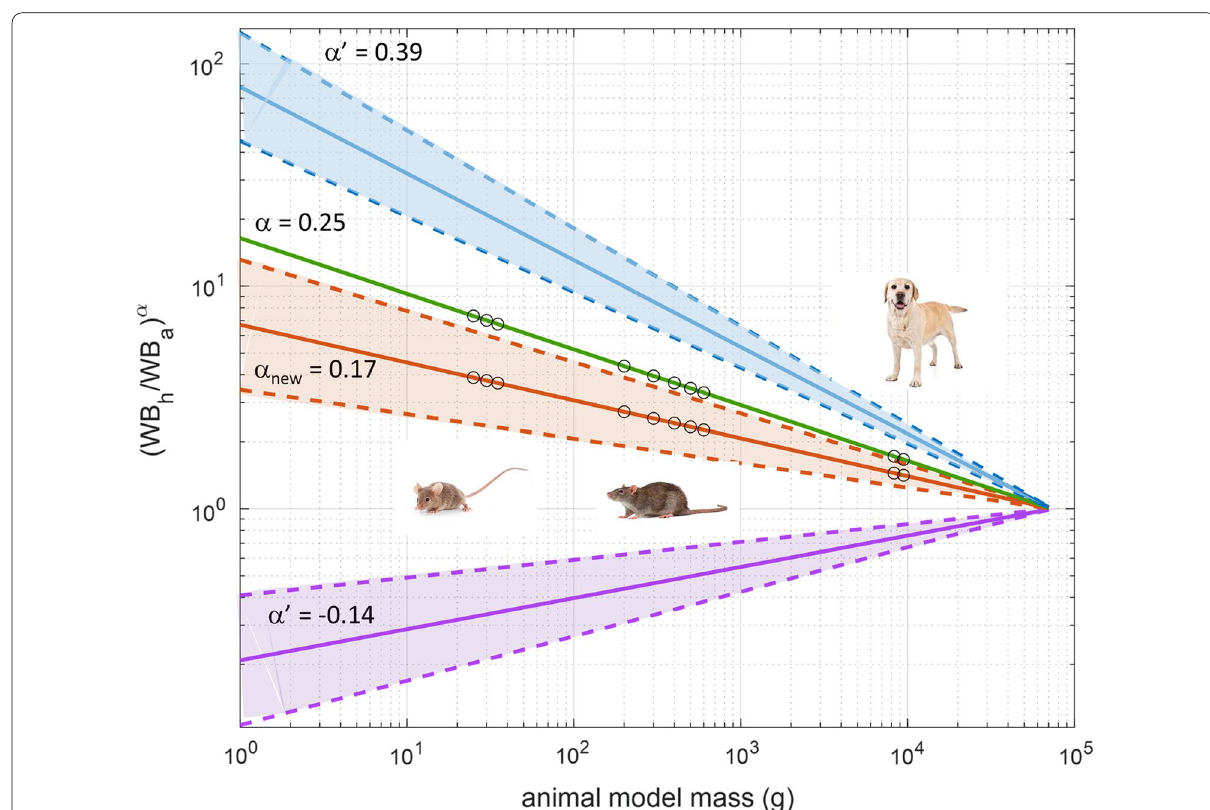
Fig. 1 Variation of the scaling factor k b (WB h /WB a ) α as a function of the animal body mass. The figure shows how the scaling factor (WB h / = WB a ) α , applied in M3 and M4, varies according to the animal body mass, for a mass of 73 kg (human adult male reference phantom). Four curves are presented, considering the reference α 0.25 (green line) [19, 20, 23], the α new 0.17 (orange line) obtained experimentally for [ 68 Ga] = = NODAGA-RGDyK, as well as the lowest and the highest organ α ′ values, i.e. α ′ 0.14 (magenta line) and α ′ 0.39 (blue line), found in this study = − = for liver and red marrow, respectively. The shadow areas represent the uncertainties around the calculation of α new and of α’ extremes (see Table 4). The circles represent the scaling factors corresponding to the masses of the murine, rat and canine models implemented in OLINDA/EXM 2.0. In the case of a 25 g mouse, the scaling factors are 7.35 and 3.88 for α 0.25 and α 0.17, respectively. Images of animals and humans are copyright-free = = images taken from the Internet